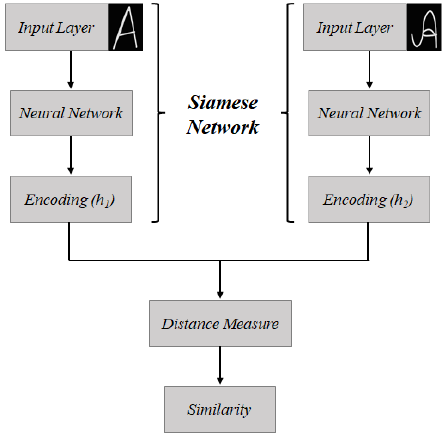
Figure 1. Schematic of the operation of the conventional Siamese Network, used for correspondence between two images. In this case, there is an example, for the correspondence of a letter “A” written in different